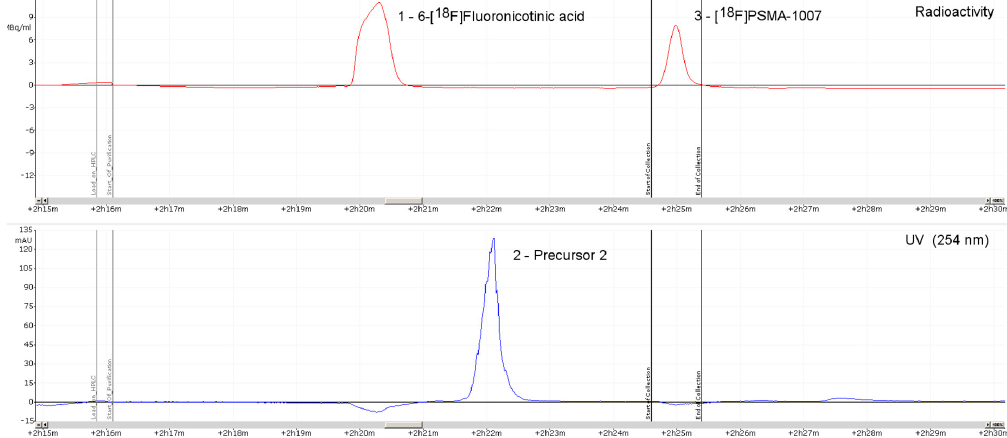
Figure 5. Radio-chromatogram of the [ 18 F]PSMA-1007 separation on integrated HPLC of the Trasis AllInOne